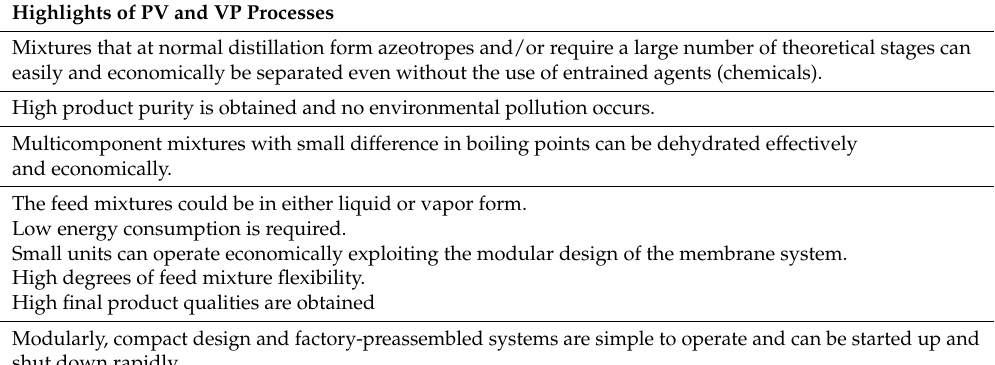
Table 1. Main advantages of the use of PV and VP technologies [34].